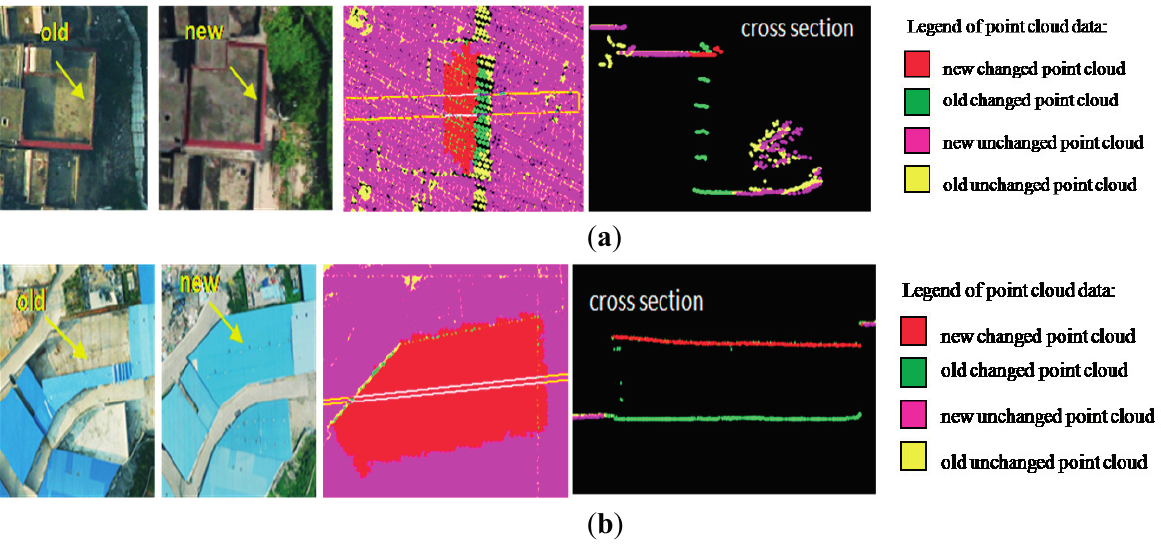
Figure 7. Details of corridors and buildings under construction ( first column : old orthophoto; second column : new orthophoto; third column : superposition of the old and new point clouds; fourth column : cross-section of the yellow rectangle area in the third column; fifth column : legend of the point cloud data).